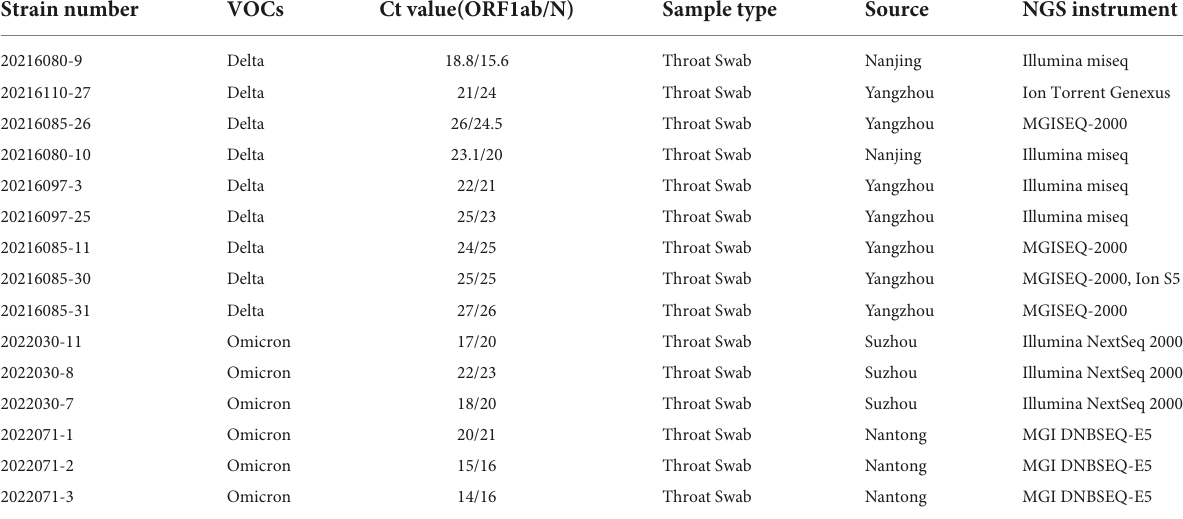
TABLE 1 The information of 15